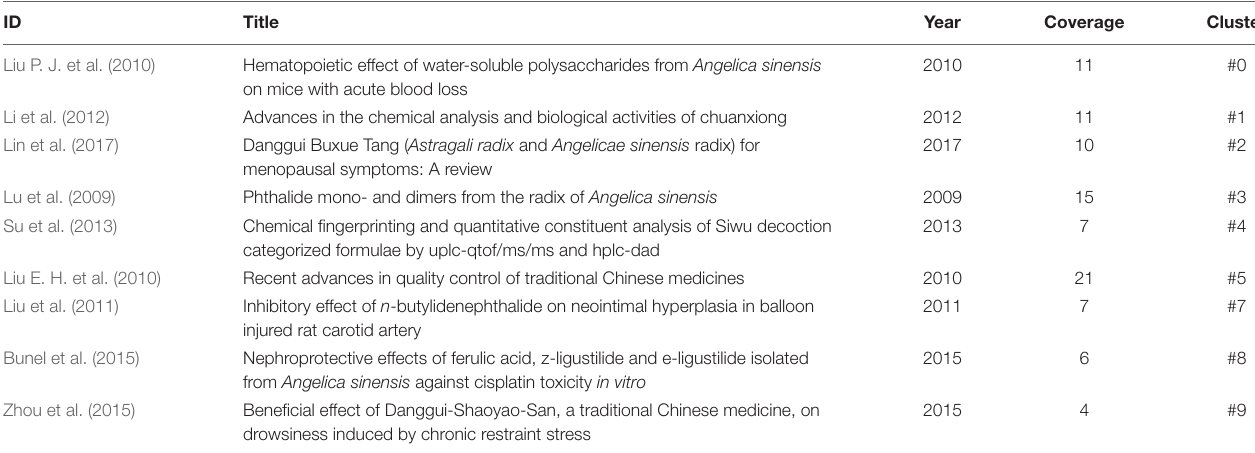
TABLE 5 | The most active citing article in each